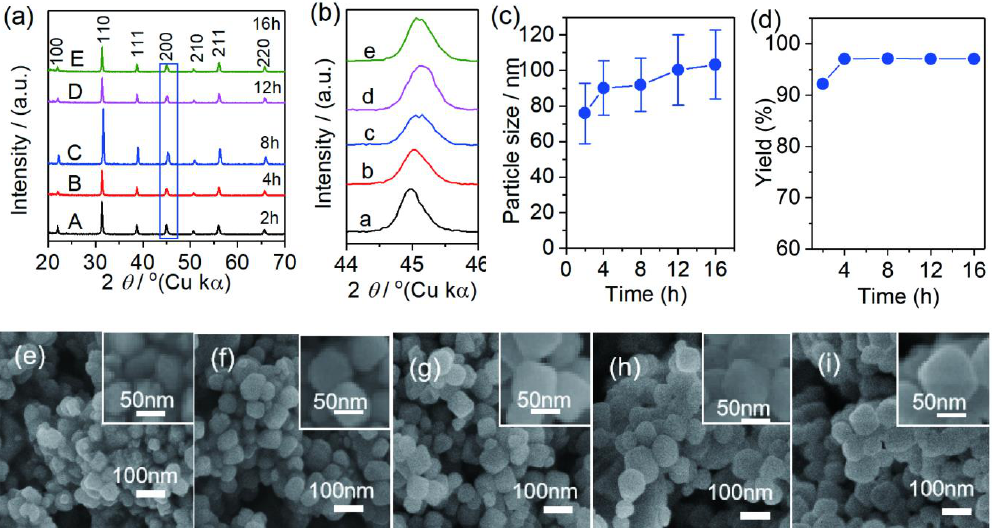
Figure 5. XRD patterns ( a , b ), particle sizes and yields ( c , d ), and SEM images ( e – i ) of the BaTiO 3 nanocrystals obtained with R Ba / Ti = 2.0([NaOH] = 2.0 mol L − 1 , pH ≈ 13.6) by hydrothermally treating at nanocrystals obtained with R Ba/Ti = 2.0([NaOH]=2.0 mol L −1 , pH ≈  13.6) by hydrothermally treating at 210 ◦ C for various times ( t = 2–16 210 °C for various times ( t = 2–16 h).